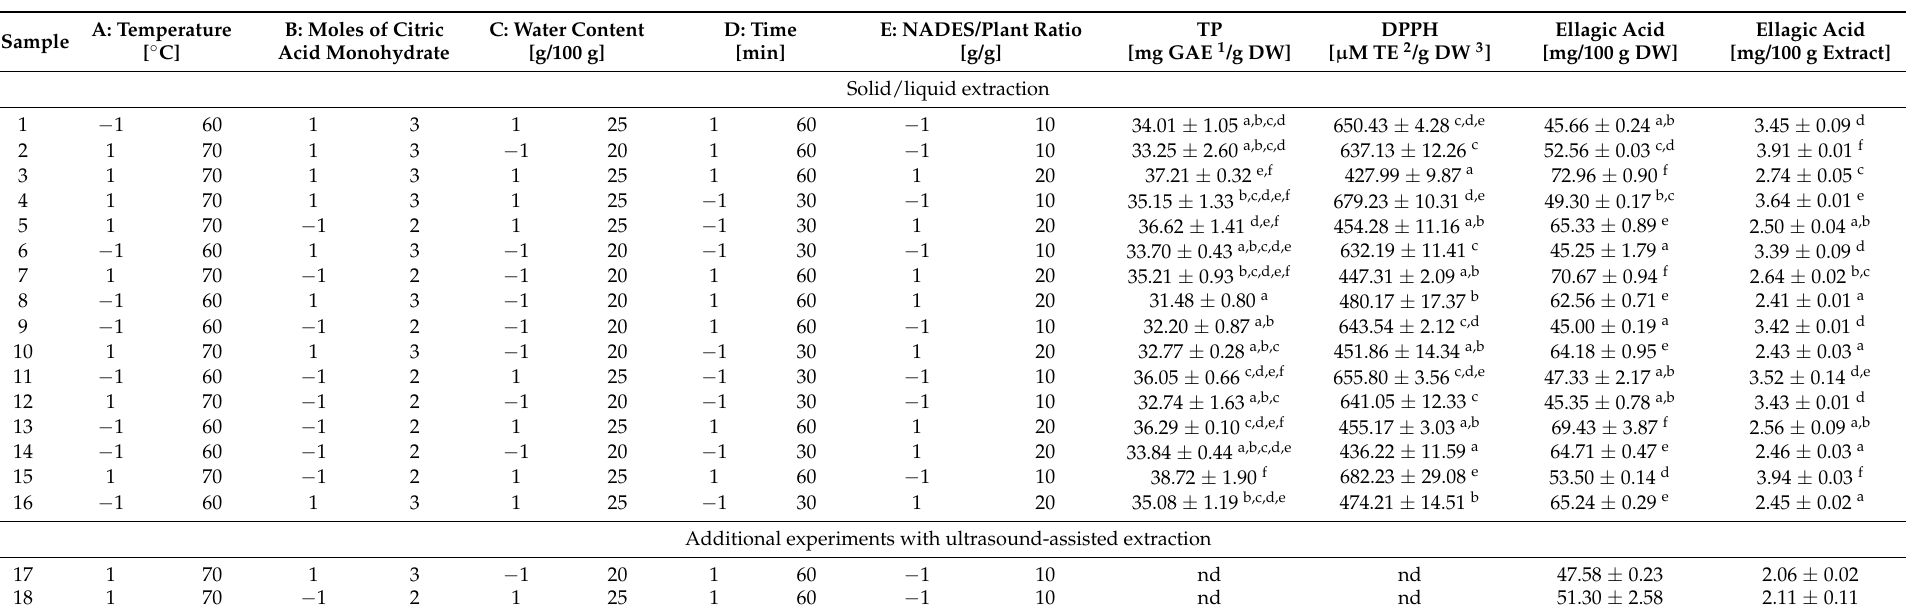
Table 2. 2 5 − 1 factorial design with process parameters of solid/liquid extraction and experimentally obtained values of total polyphenol (TP) content, antioxidant activity (DPPH), and ellagic acid content. Citric acid monohydrate, betaine (1 mol), and water were used for NADES